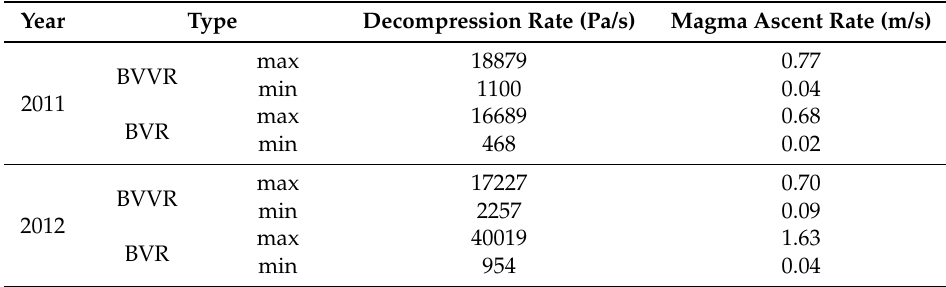
Table 2. The result of estimation of decompression rate (Pa/s) and magma ascent rate (m/s) based on Black Vesicular Volcanic Rock (BVVR) and Black Volcanic Rock (BVR) juvenile materials type in Sakurajima at AD 2011–2012.